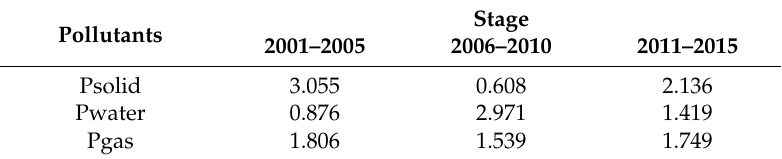
Table 3. The average value of the decoupling elastic index in each stage.